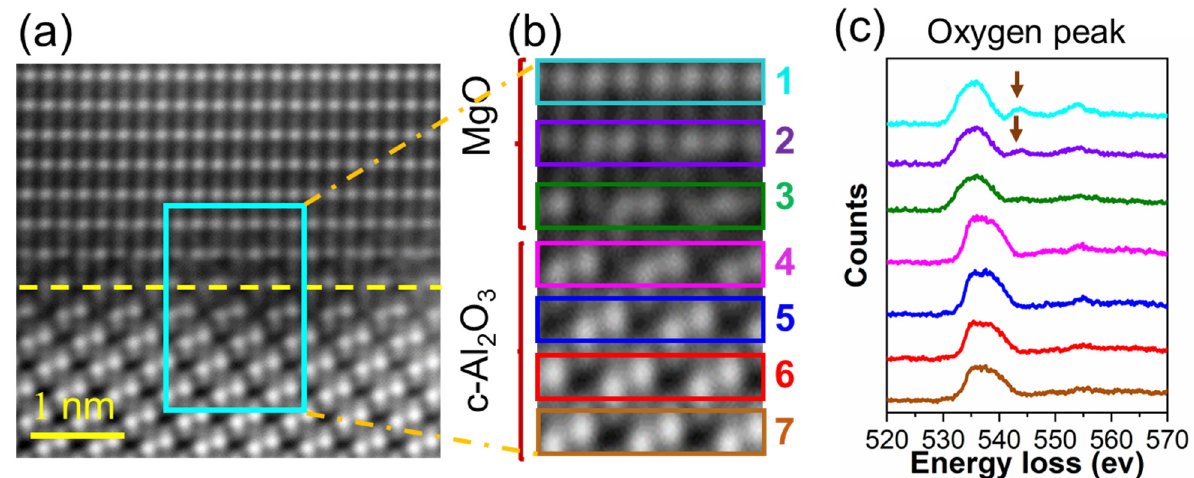
Figure 7. ( a , b ) Atomic-resolution HAADF image of MgO grown on c-Al 2 O 3 , ( c ) plane-by-plane EELS spectra of O-K from the MgO, and c-Al 2 O 3 corresponding to planes shown in ( b ).